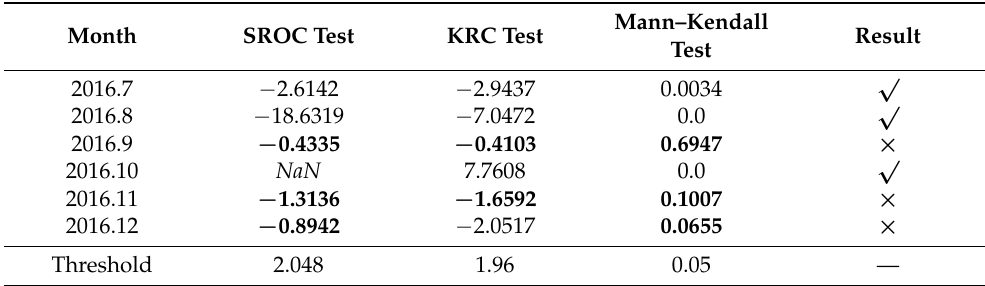
Table 6. Results of trend test.